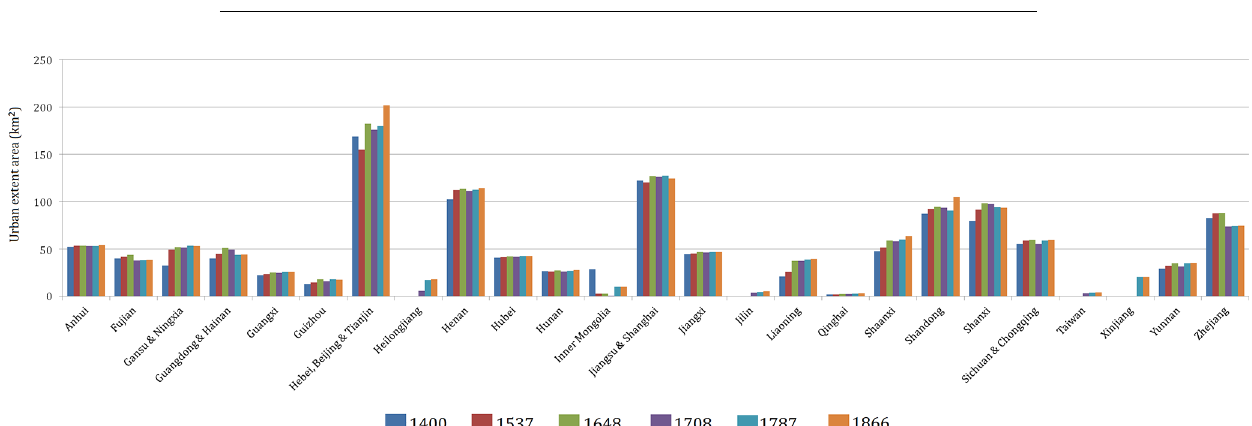
Figure 10. Provincial distribution of urban extents in 1400, 1537, 1648, 1708, 1787, and 1866.